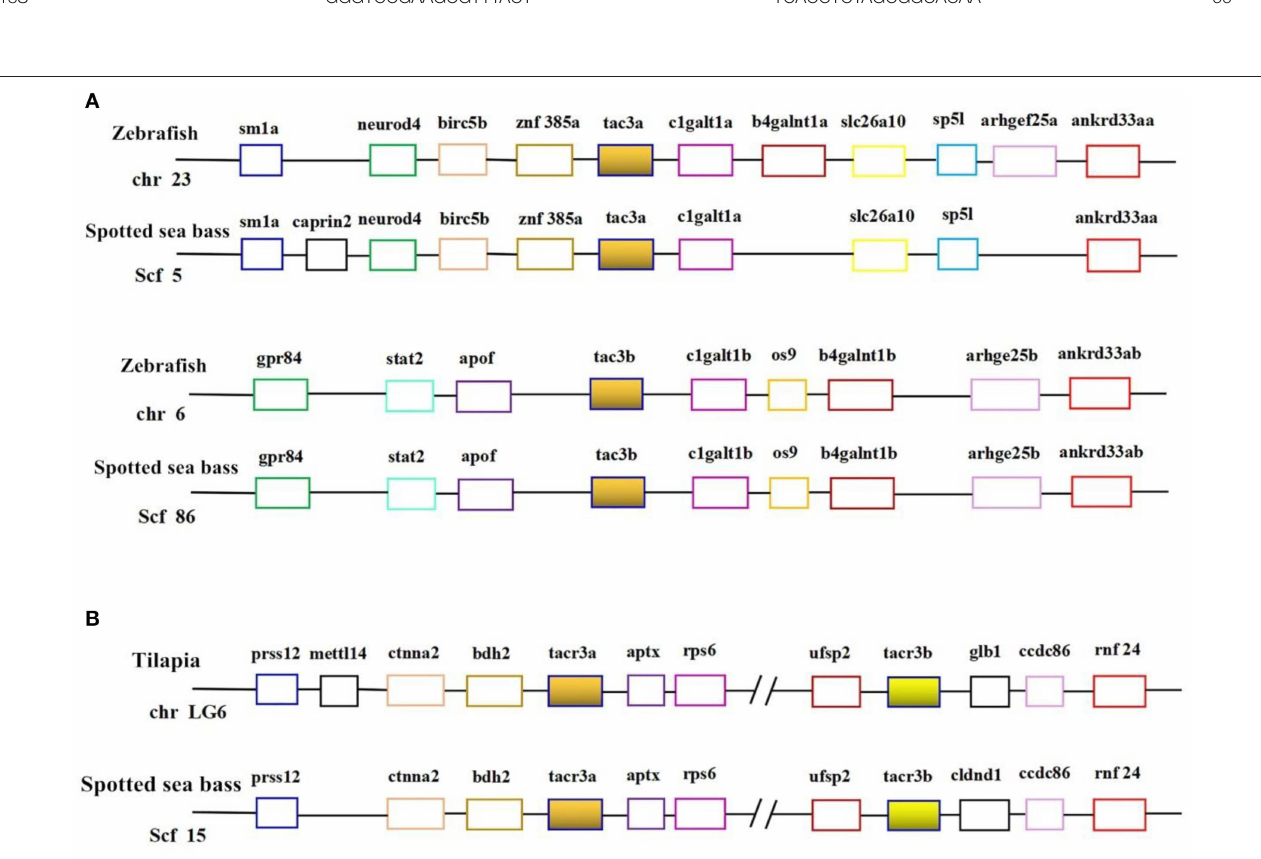
FIGURE 1 | Syntenic analysis of tac3s (A) in zebrafish and spotted sea bass and tacr3s (B) in tilapia and spotted sea bass. In this map, the spotted sea bass genes are immediately proximal to each other on the chromosome, and the zebrafish tac3s genes and tilapia tacr3s genes are located in the same chromosomal region.